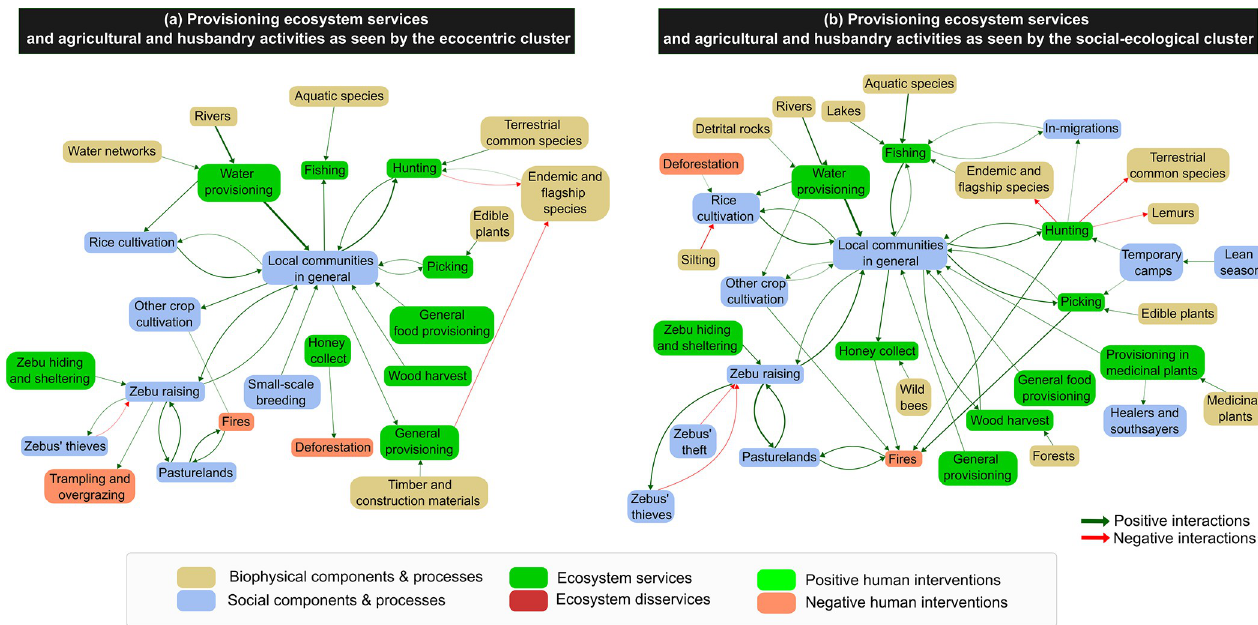
Fig 8. Group cognitive maps centered on provisioning ecosystem services and agricultural and pastoral activities in the Makay SES for each of the two clusters of respondents. Maps are based on the aggregation of the individual cognitive maps for each cluster and represented at the level of components. Only components linked with components belonging to the types ‘Agriculture and husbandry’, ‘Food production issues’, ‘Food security issues’ and ‘Provisioning ecosystem services’ are represented. Edges correspond to the positive (in green) and negative (in red) interactions between component types, and their width is proportional to their occurrence in individual cognitive maps (only interactions cited by > 2 respondents are